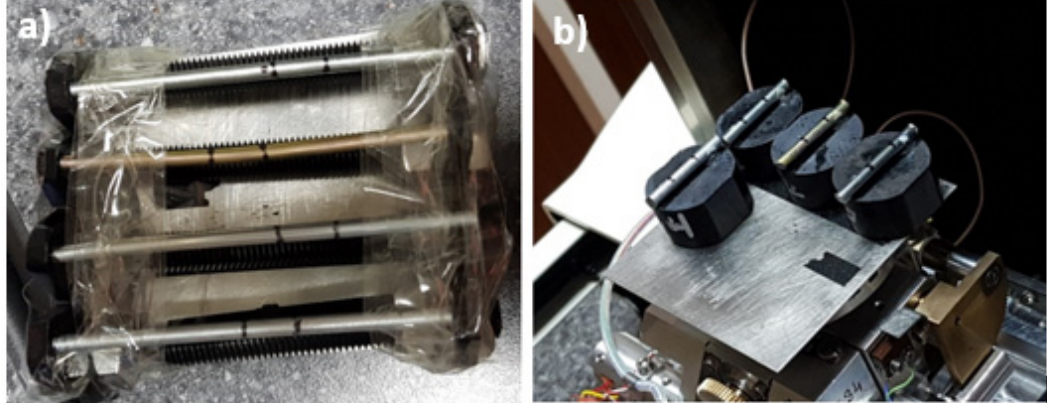
Figure 5. Example of some of the samples prepared for introduction into the SEM. ( a ) R samples; ( b ) F samples.